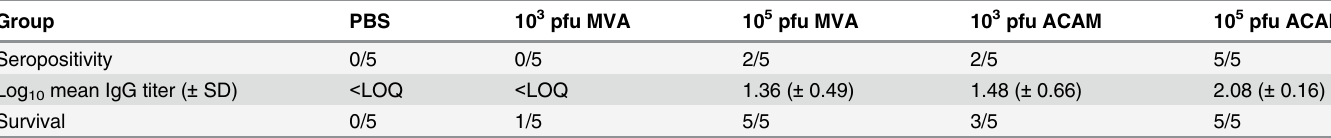
lost the most weight (Fig 1B), with a mean peak loss of about 16% on day 9 post-challenge. Weight loss among the MVA subcutaneous and percutaneous groups were similar, with peak losses of 9.6% (day 6) and 8.9% (day 7), respectively. However, mice in the MVA percutaneous group recovered more quickly (98.4% of original mean body weight on day 14) than the subcu- taneous group (94.4% mean weight on day-14). Among the ACAM2000 treatment groups (Fig 1C), the average peak weight loss was 8.8% (day-5), 7.7% (day-6), and 6.2% (day-6), for the intramuscular, subcutaneous, and percutaneous groups, respectively. In another experiment, mice in groups of five were vaccinated with 10 3 pfu or 10 5 pfu of MVA by scarification. Two other groups were similarly vaccinated with 10 3 pfu or 10 5 pfu of ACAM2000, and a control group was scarified with PBS. Antisera were collected after three weeks and mice were chal- of VV-WR. None of the mice in the PBS group had detectable IgG and all lenged with 10 LD 50 succumbed to VV-WR infection (Table 1). All mice in the 10 3 pfu MVA group had no detect- able IgG and 2/5 in the 10 5 MVA group had detectable IgG. However, 1/5 and 5/5 of mice sur- vived in the 10 3 pfu and 10 5 pfu MVA, respectively. In the ACAM2000 cohort, 2/5 and 5/5 of mice in the 10 3 pfu and 10 5 pfu groups, respectively, were seropositive. Three of five (3/5) and Table 1. Antibody response and protection after MVA and ACAM2000 inoculation by tail scarification. Group Seropositivity